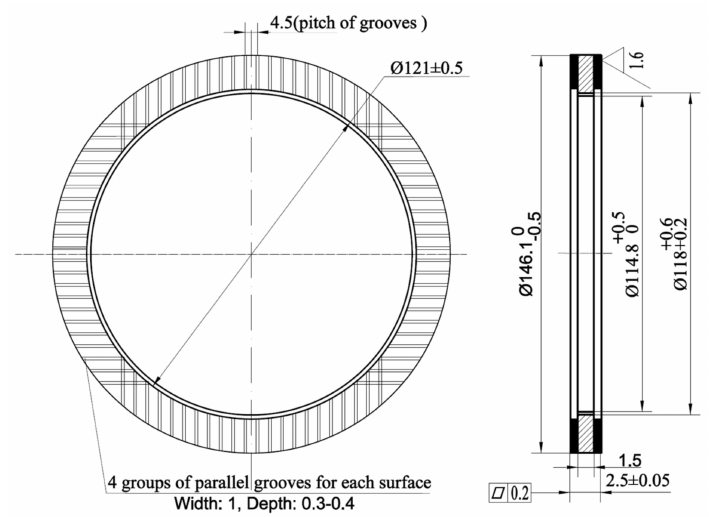
Figure 3. Schematic of the test